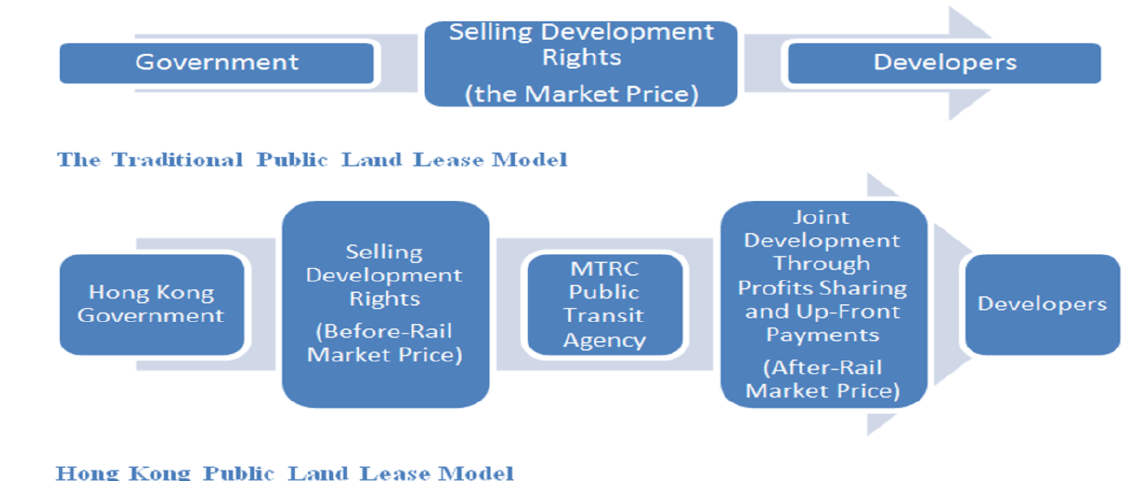
Figure 2. Hong Kong Public Land Management Model around Public TransitStations – Source: (Elnagdy & AbdelAty,